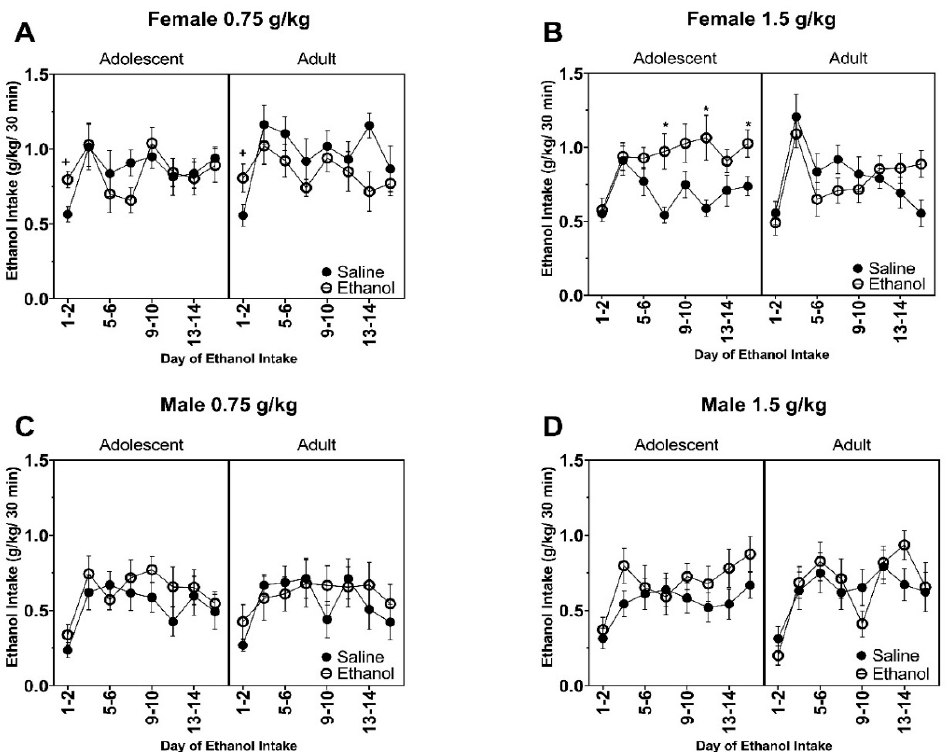
Figure 2. Data are presented as ethanol consumed (g / kg) for the 30 min session. Female rats chronically exposed to ( A ) 0.75 g / kg and ( B ) 1.5 g / kg. Male rats chronically exposed to ( C ) 0.75 g / kg and ( D ) 1.5 g / kg. + indicates ethanol is significantly greater than saline when collapsed across age. * indicates ethanol-exposed significantly greater than ethanol-exposed.